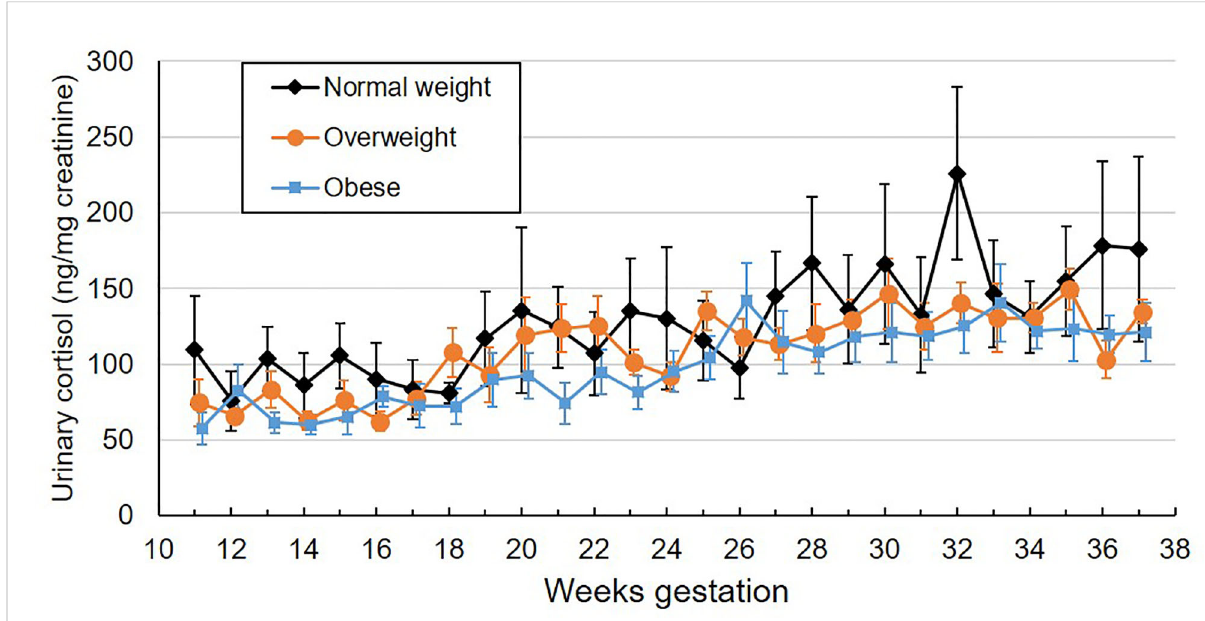
FIGURE 1 Mean weekly overnight urinary cortisol levels (ng/mg creatinine) across gestation by maternal pre-pregnancy BMI category. Values are mean ± standard error.